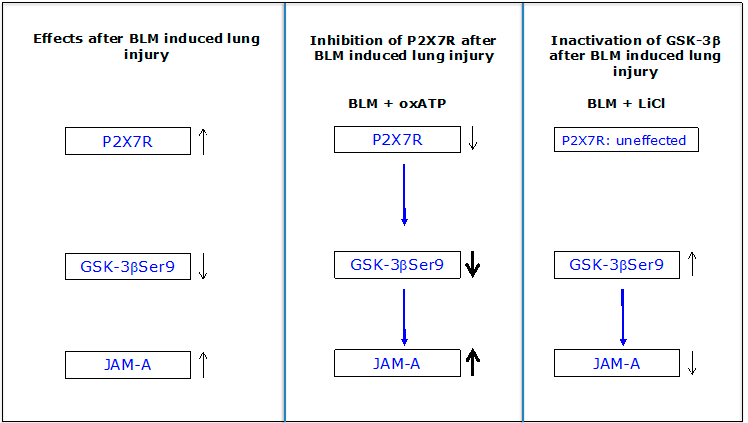
Figure 6. BLM treatment results in increased protein levels of P2X7R and JAM-A as well as in a reduced content of the inactive form of GSK-3 β GSK-3 β (Ser9). After inhibition of P2X7R by oxATP under BLM exposure, the e ff ect on both proteins is further enhanced. Inactivating of the GSK-3 β by LiCl under BLM exposure directly leads to a reduction of JAM-A. The influence of P2X7R on JAM-A is rather